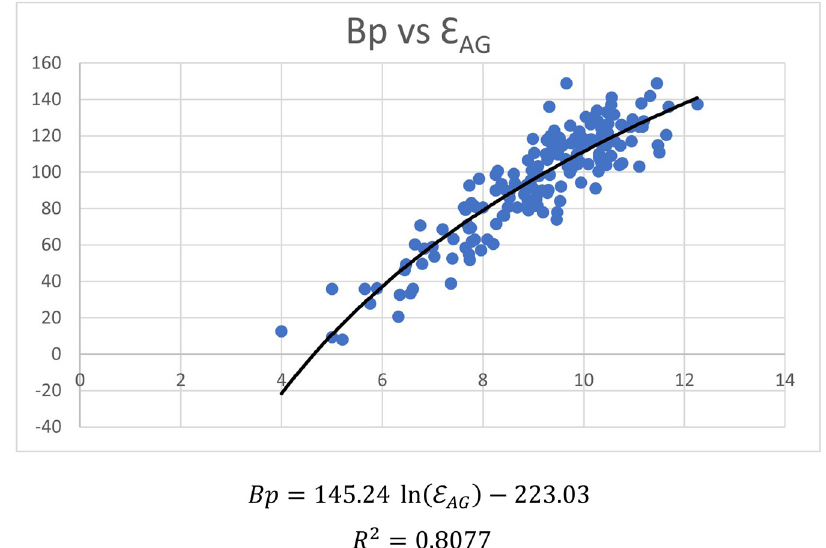
Figure 5: Logarithmic regression Bp versus AG E